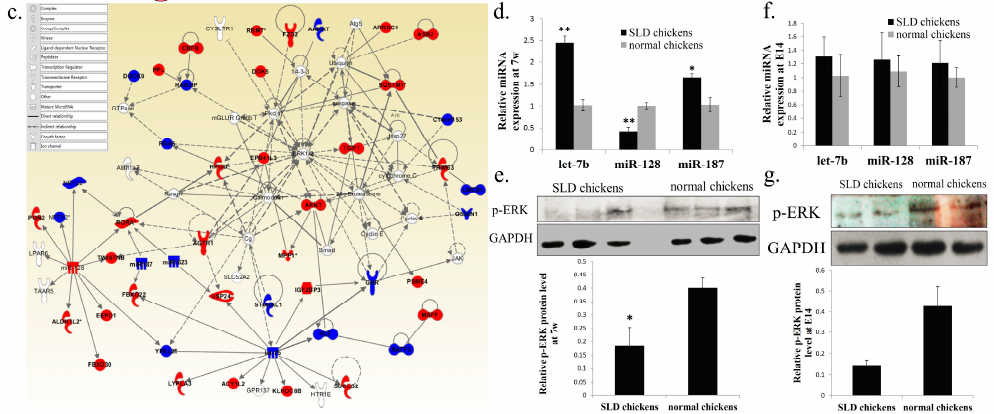
Figure 3. Network and functional analysis of the DEGs and DEMs at 7w. ( a ) Interaction network of DEGs and DEMs at 7w based on MAGIA and Cytoscape software. Green circles represented DEMs and pink circles represented DEGs. Length edges are log p value; ( b ) Heat map of putative pathways of DEMs by DIANA miRPath analysis; ( c ) IPA network showing the interaction between DEMs and DEGs at 7w. This network corresponds to cellular development and muscle growth, with ERK1/2 as a hub. Red nodes are the genes or miRNAs that are down-regulated in the SLD chickens at 7w, blue nodes are the genes or miRNAs that are up-regulated in the SLD chickens at 7w; ( d ) qPCR results showed that let-7b, miR-128 and miR-187 are differentially expressed between the SLD chickens and normal chickens at 7w; ( e ) The protein expression of phospho-ERK1/2 (p-ERK) between the SLD chickens and normal chickens at 7w; ( f ) qPCR results of the expressions of let-7b, miR-128 and miR-187 between E14 SLD and normal chickens; ( g ) The protein expression of phospho-ERK1/2 (p-ERK) between E14 SLD ( left ) and normal ( right ) chickens. Results are shown as the mean ± S.E.M. (Standard Error of Mean) of three samples (Figure 3g has only two samples). One sample t test was used to assess the different between the SLD chickens and normal chickens. * p < 0.05, ** p < 0.01.